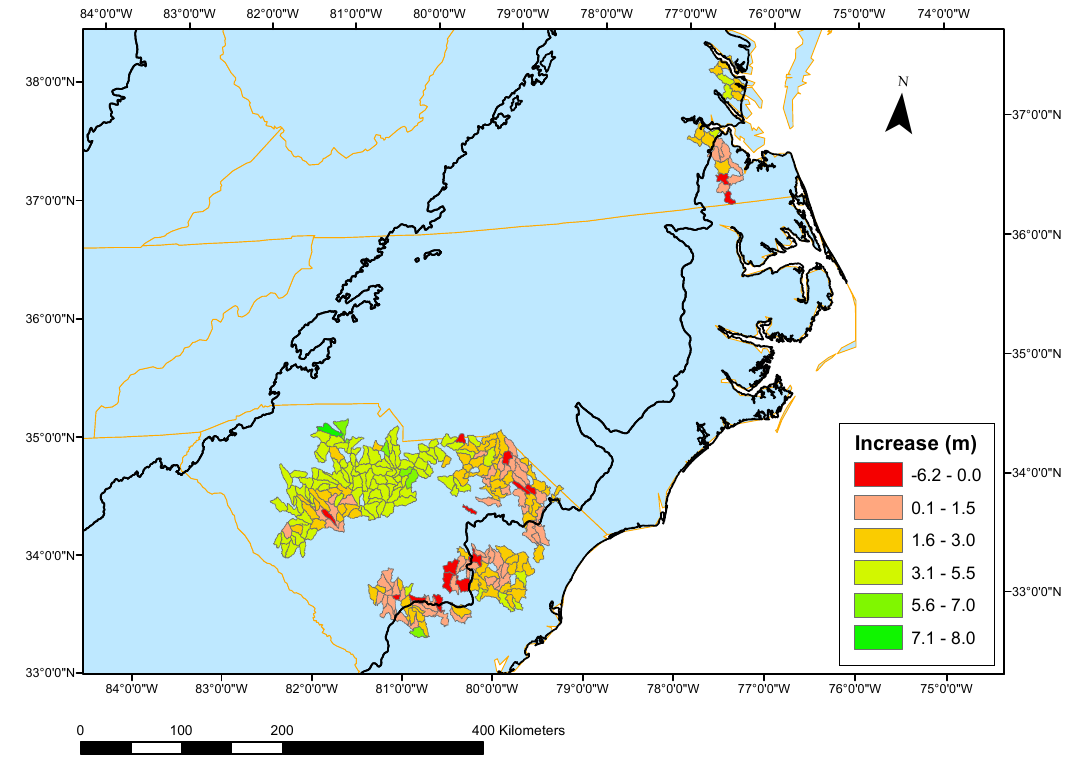
Figure 12. The average site index difference (between lidar-based and historical SSURGO estimates) for stands that fall in the hydrological unit is shown. Only hydrological units with at least 4.5 ha of surveyed forest stand area (50 pixels) are considered. The thick black lines here demarcate ecoregions (EPA level 2 ecoregions as per Omernik 1987 [44]), see text for more